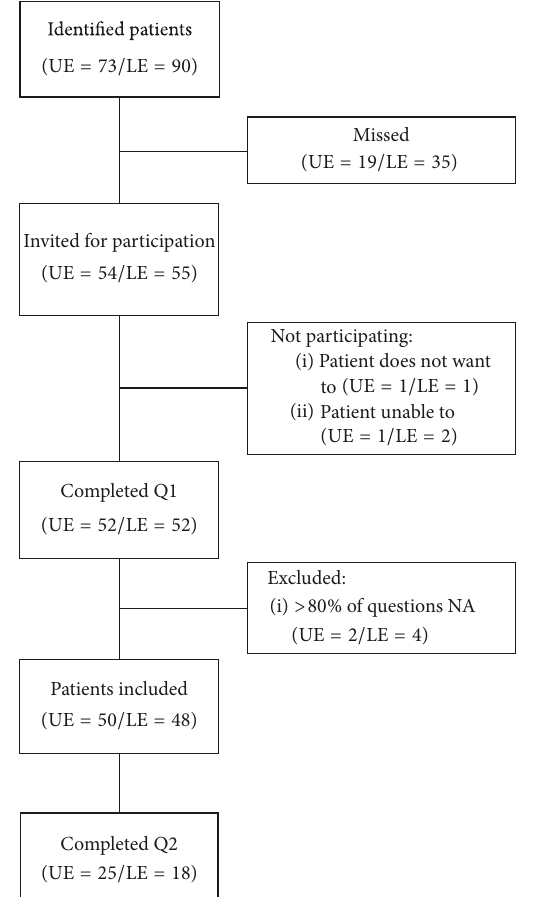
Figure 1: Flowchart of participating patients.